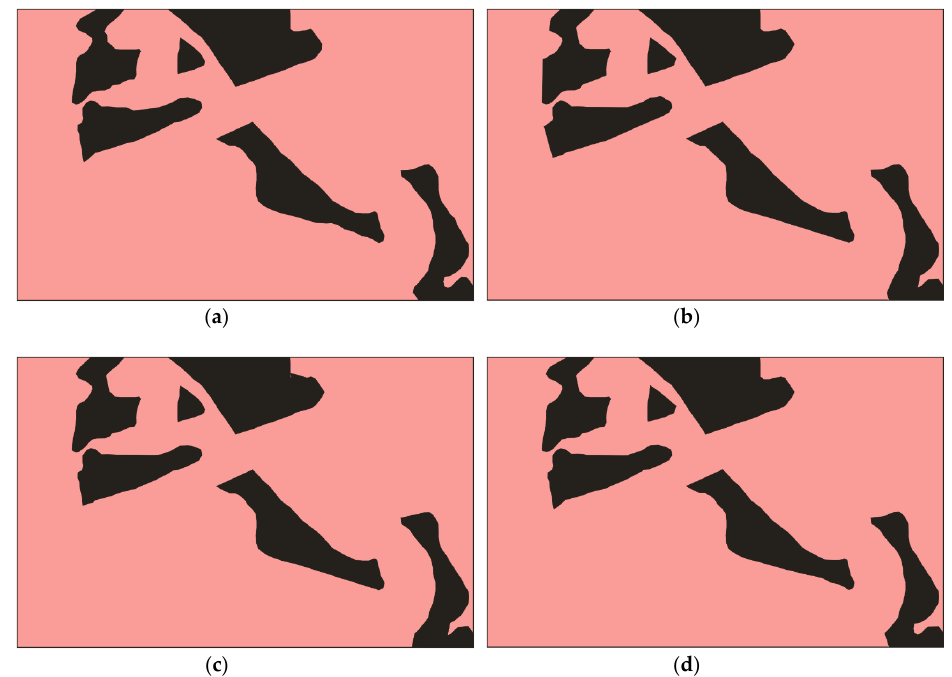
Figure 5. Effects of contourlet subbands for Pune image: ( a ) reference; ( b ) U-cnet_1; ( c ) U-cnet_2; ( d ) U-cnet_3.